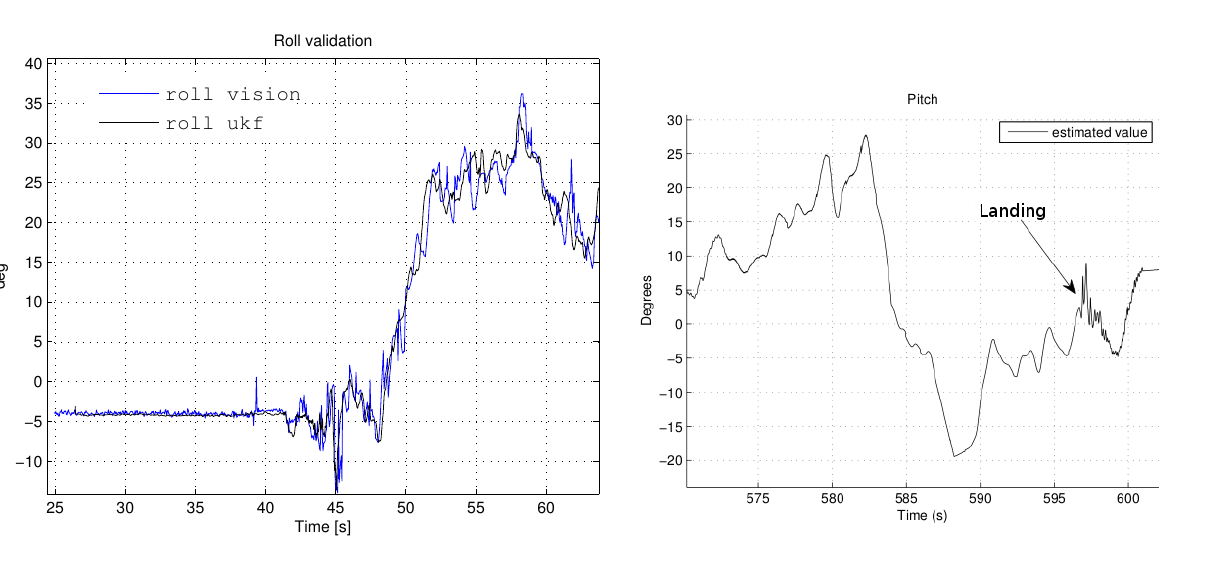
Figure 12. Roll angle comparison between vision system and UKF estimation and Pitch angle at the landing time after ten minutes of flight.